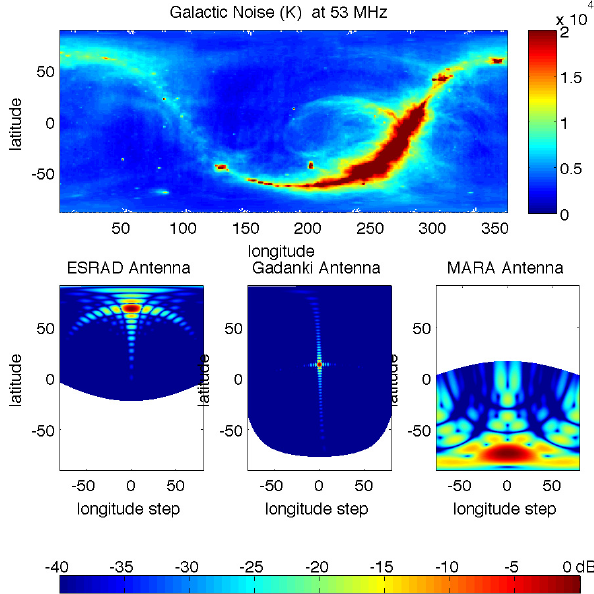
Fig. 1. Upper panel: sky noise at 53MHz, in celestial equatorial coordinates, from an assimilation of radio-astronomical surveys (de Oliveira-Costa et al., 2008). Lower panels: antenna beam patterns projected to the same coordinate system for the ESRAD, Gadanki and MARA